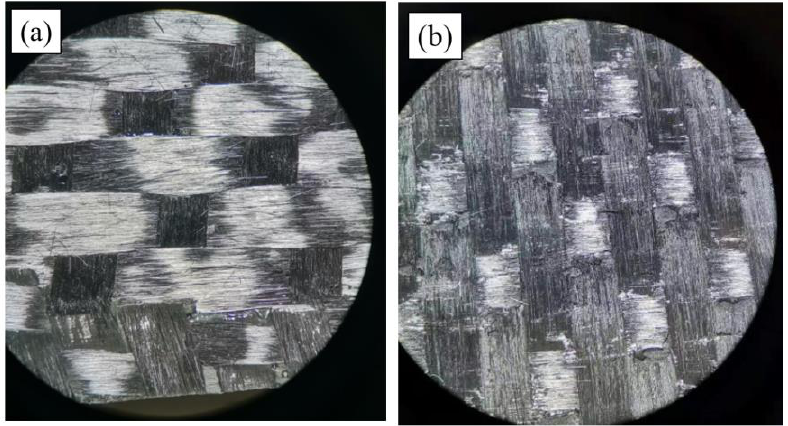
Figure 12. Photos by optical microscope: ( a ) original specimen; ( b ) MWCNTs toughening speci- men.